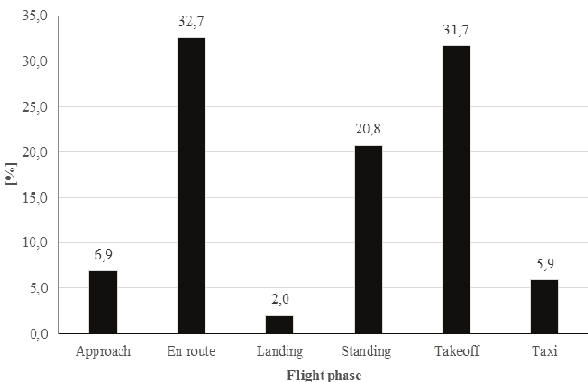
Fig. 16. Flight phases share when powerplant caused event took place